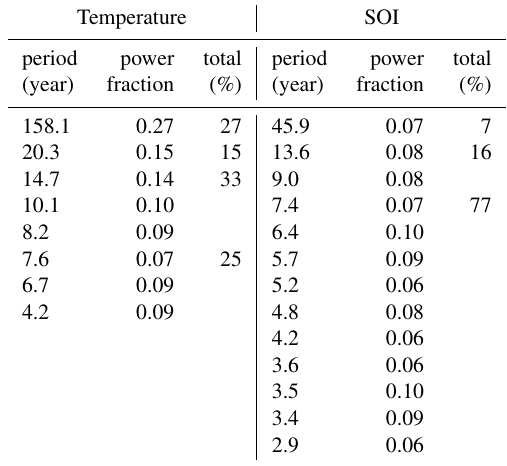
Table 1. Power fraction of the frequency found in the mean width of tree-ring series and annual mean temperature anomaly and SOI signals. Temperature